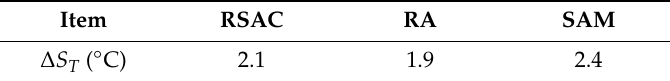
Table 5. The results of storage stability.